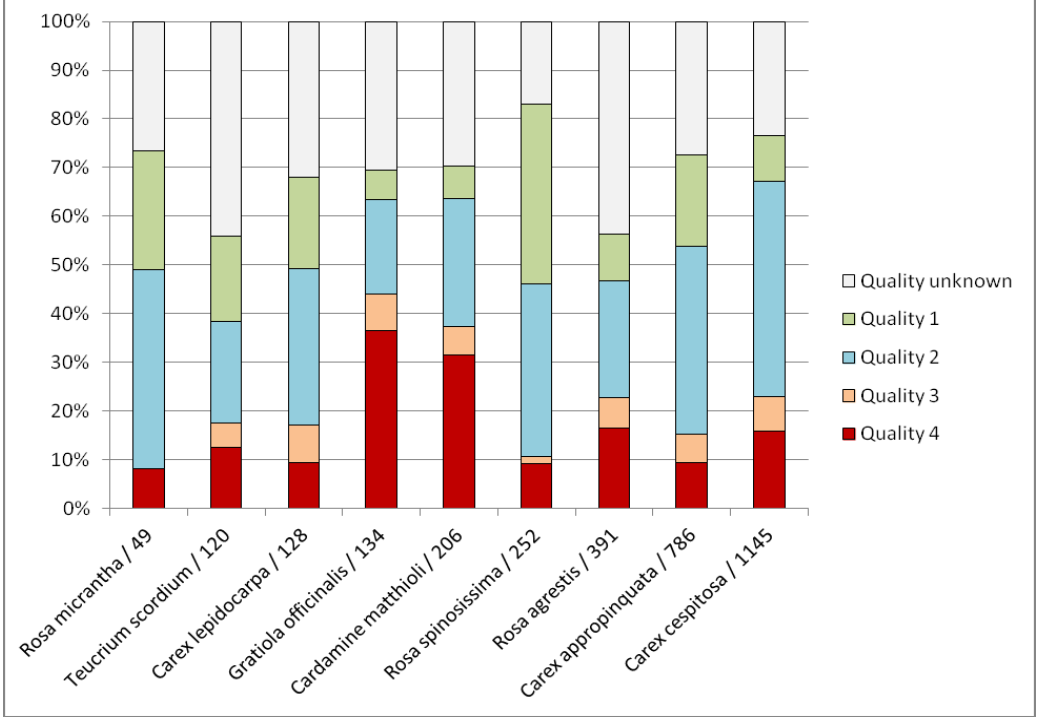
Figure 4. Percentages of habitats’ quality with species occurrences.